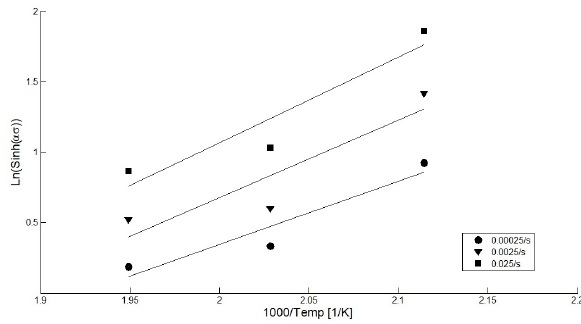
Figure 5: Plotting Ln(sinh( ασ )) against 1000/T p at the same strain rates and different temperatures and strain = 0.2.